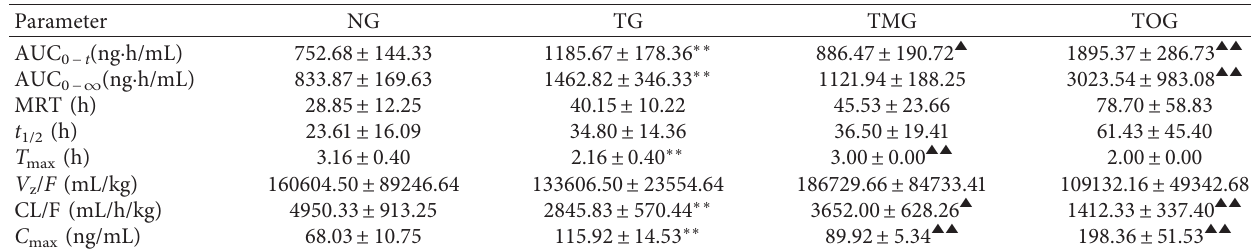
Table 5: Pharmacokinetic parameter of TMEA in rat after intragastric administration of four groups ( n �